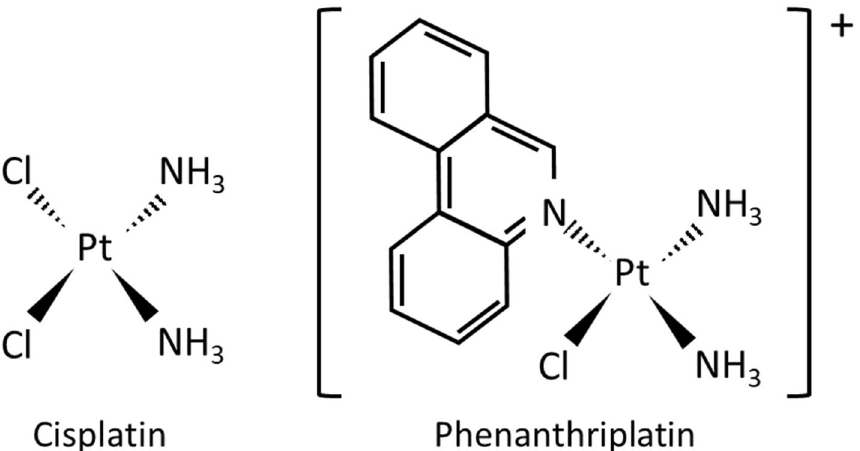
Figure 1. Chemical structures of cisplatin and phenanthriplatin. Cisplatin is a bifunctional platinum(II) complex with two chloride leaving ligands. The monofunctional platinum(II) complex, phenanthriplatin, has one chloride leaving ligand, and steric bulk in the form of a heterocyclic phenanthridine ligand placed cis to the platinum coordinating